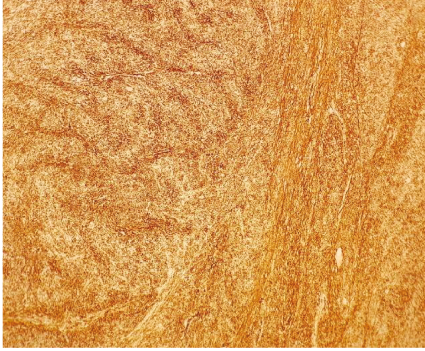
Figure 4: The spindle cells show positivity for vimentin ( × 200).